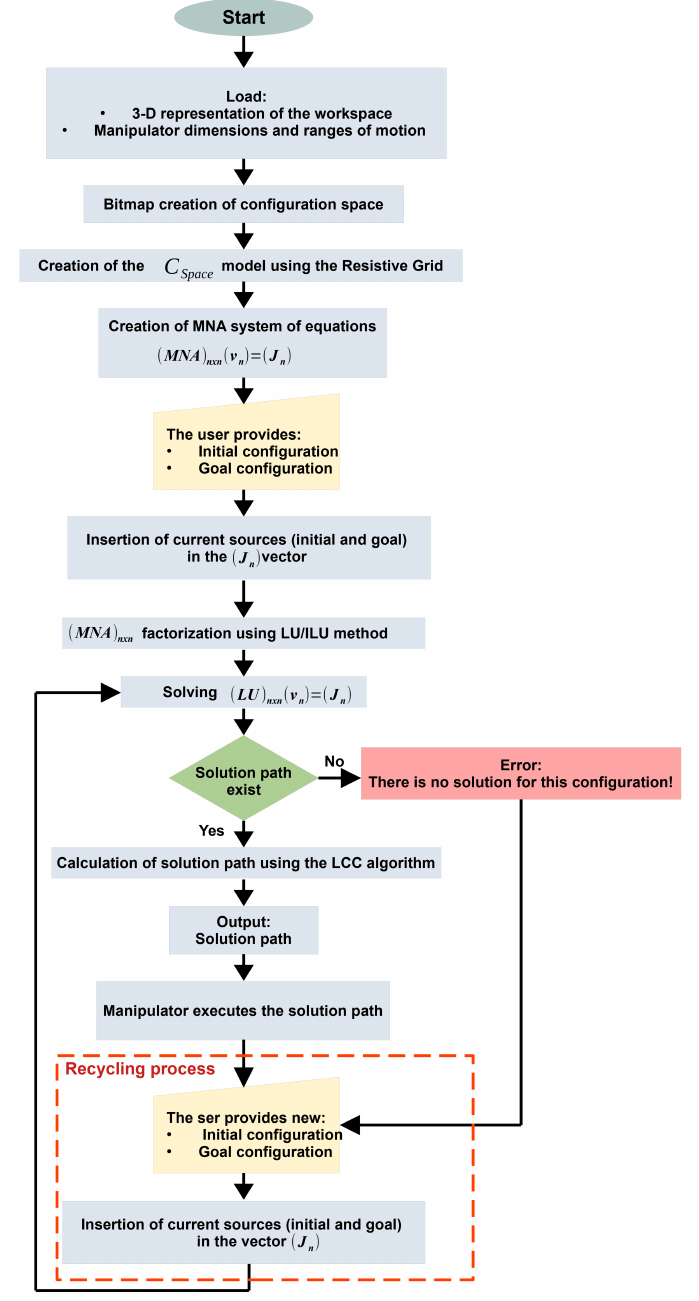
Figure 8. Flowchart of multiple-query RGPM for high-DOF